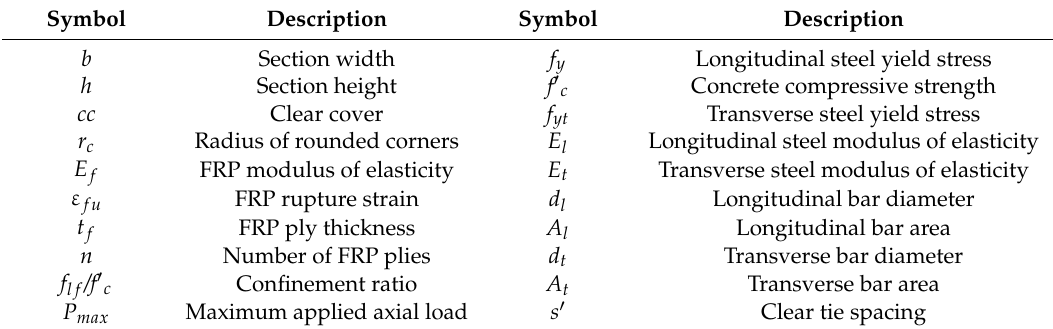
Table 11. Notations for specifications.